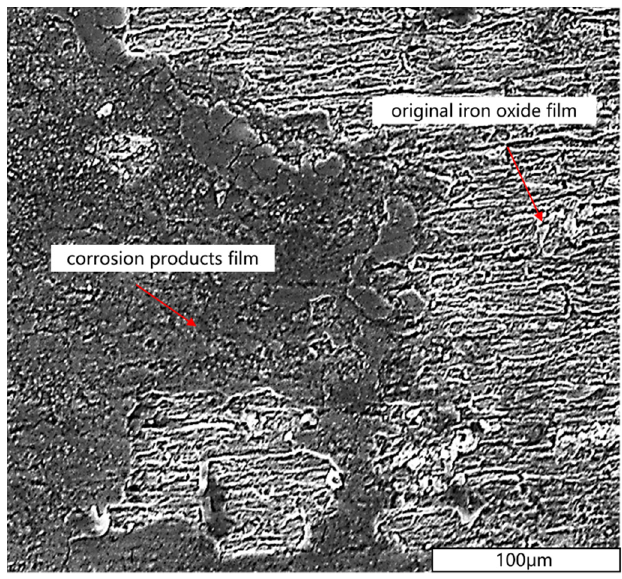
Figure 9. SEM microstructure of prestressed steel wire surface in NH 4 SCN solution.